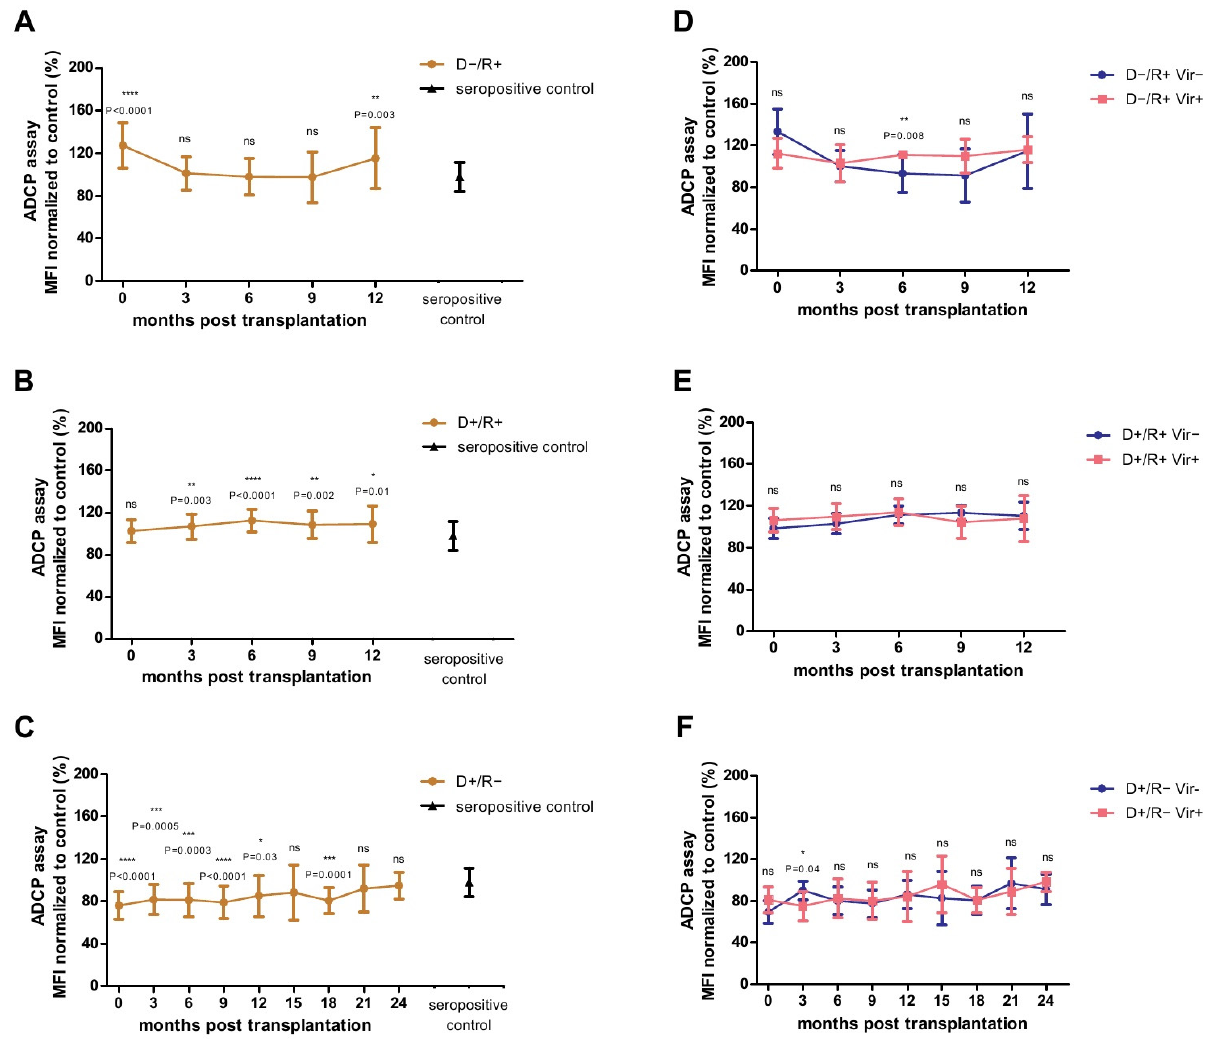
Figure 3. Analysis of the Antibody-Dependent Cellular Phagocytosis (ADCP)-Assay with plasma obtained from D − /R+ ( A , D ), D+/R+ ( B , E ) and D+/R − ( C , F ) lung transplant recipients (LTRs) after lung transplantation (LTX). D − / R+ and D+/R+ LTRs were tested at 0, 3, 6, 9 and 12 months post-LTX. D+/R − LTRs were tested at 0, 3, 6, 9, 12, 15, 18, 21 and 24 months after LTX. Data are shown as mean values ( ± SD). Mean value of the HCMV-seropositive control cohort (N = 20) is indicated as black triangle ( ± SD) ( A – C ). The normalized mean fluorescence intensity (MFI) at each time point was compared with that of the seropositive control patients by ANOVA and Dunn’s post-test ( A – C ). MFI at each time point of viremic (>1000 copies/mL) (pink) LTRs was compared with that of non/low-viremic (<1000 copies/mL) (blue) LTRs by Mann-Whitney test ( D − F ); p < 0.05 was considered significant. * p < 0.05; ** p < 0.01; *** p < 0.001; **** p < 0.0001. MFI: mean fluorescence intensity.